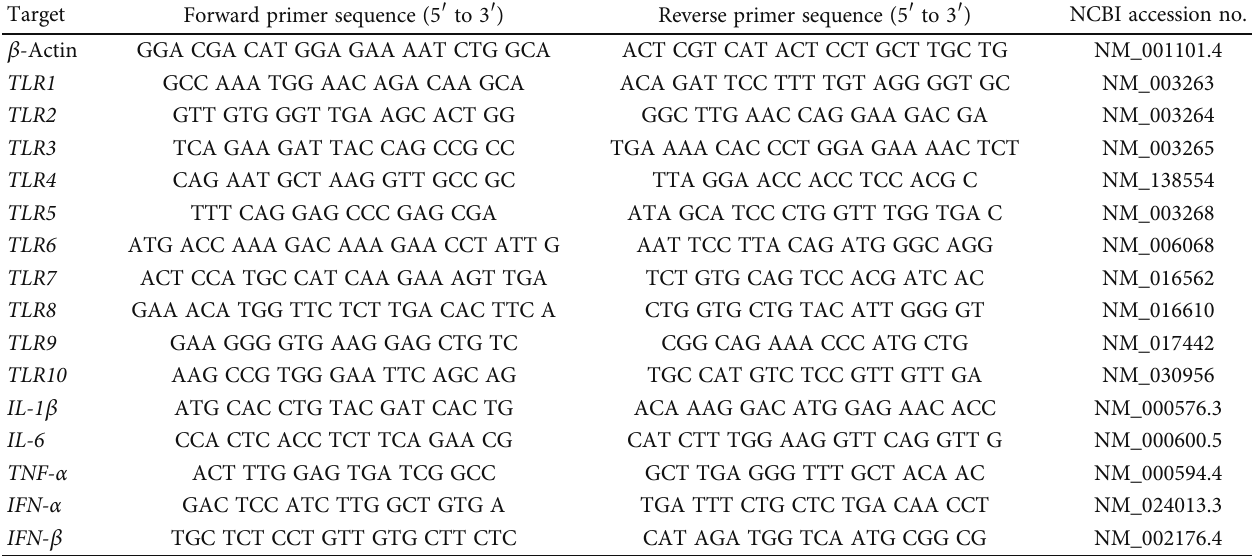
Table 1: Primer sequences used in real-time qRT-PCR analysis. Target Forward primer sequence (5 ′ to 3 ′ ) Reverse primer sequence (5 ′ to 3 ′ ) NCBI accession